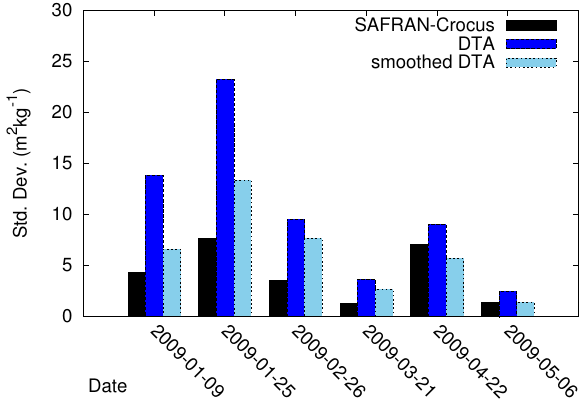
Fig. 9. SSA Standard deviations of SAFRAN-Crocus (black), DTA Fig.9. SSAStandarddeviationsofSAFRAN-Crocus(black), DTA(blue)andsmoothedDTA(lightblue),over (blue) and smoothed DTA (light blue), over the six studied the six studied dates.